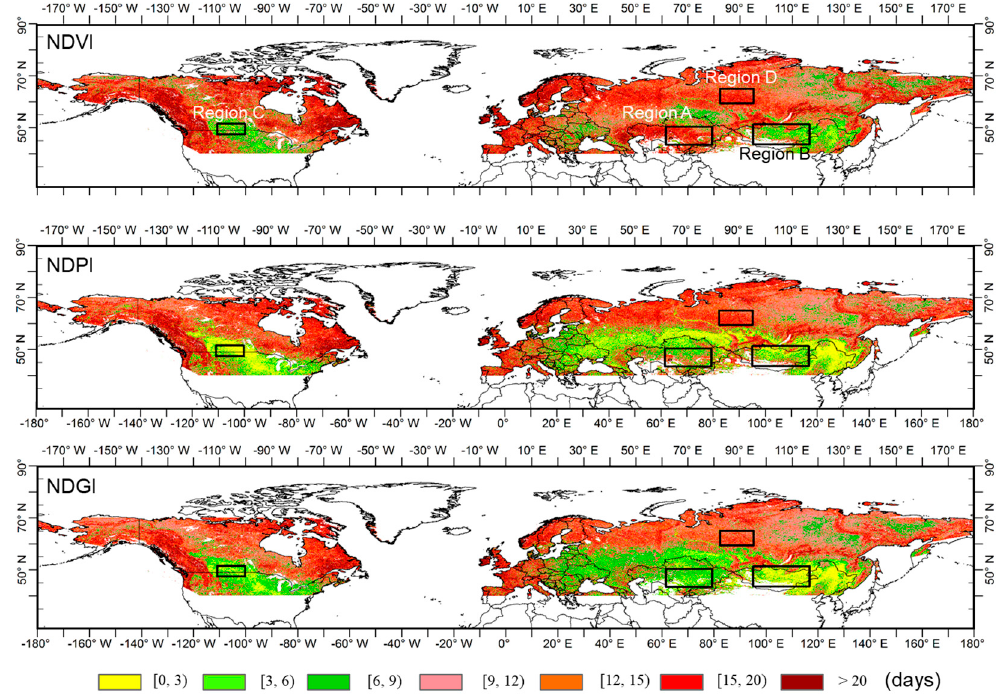
Figure 7. The spatial distribution of the uncertainty of GUD estimations for NDVI, NDPI, and NDGI over the north of 40 ° N. Data in each pixel are the average of GUD uncertainty during 2001–2016 for this pixel. Four local areas (regions A, B, C, and D) were highlighted in this figure for further detailed comparisons.